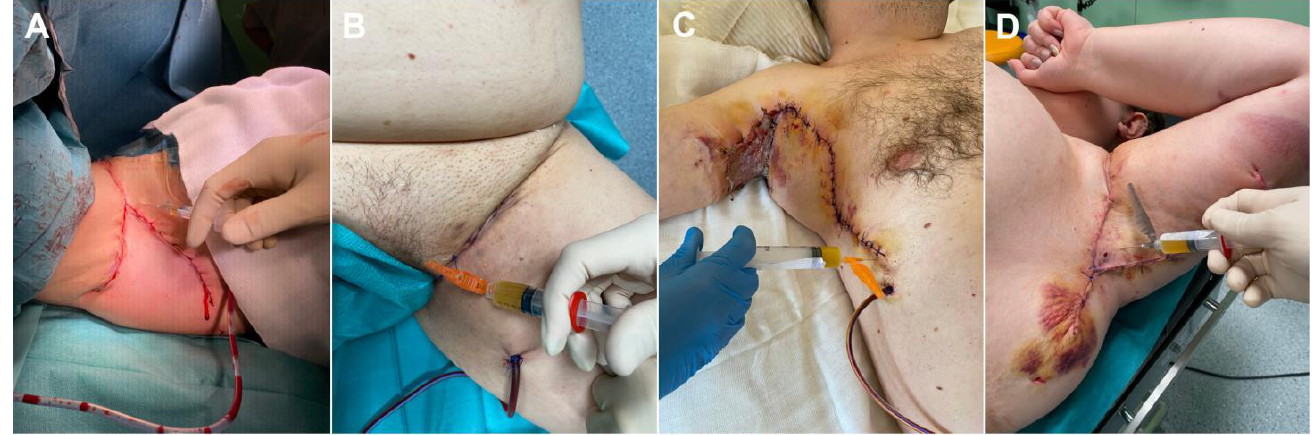
Figure 2. Platelet-rich plasma injections: ( A ) and ( B ) intraoperative images—injections after flap fixation; ( C ) PRP injection to local skin flap—1st day post-surgery (right axilla); ( D ) PRP injection to local skin flap—3rd day post-surgery (left axilla). Legend: PRP, platelet-rich plasma.